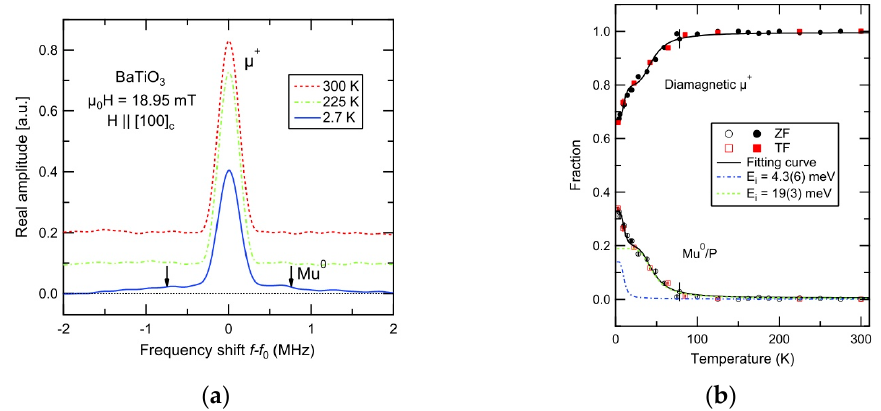
Figure 19. ( a ) Fourier transform of the µSR spectrum of BaTiO 3 . ( b ) Temperature dependences of the fractional yields of µ + and Mu 0 [37].